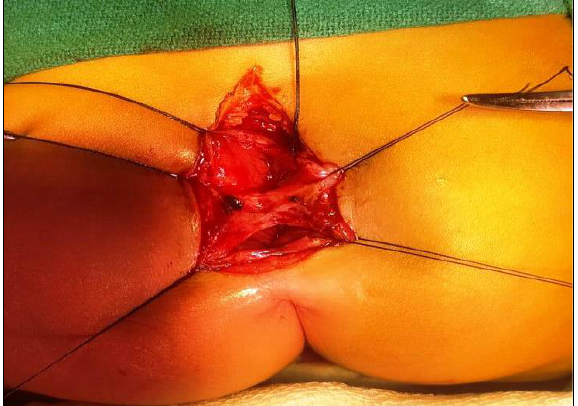
Figure 2: Intraoperative photograph showing thick septum after opening rectum from posterior sagittal